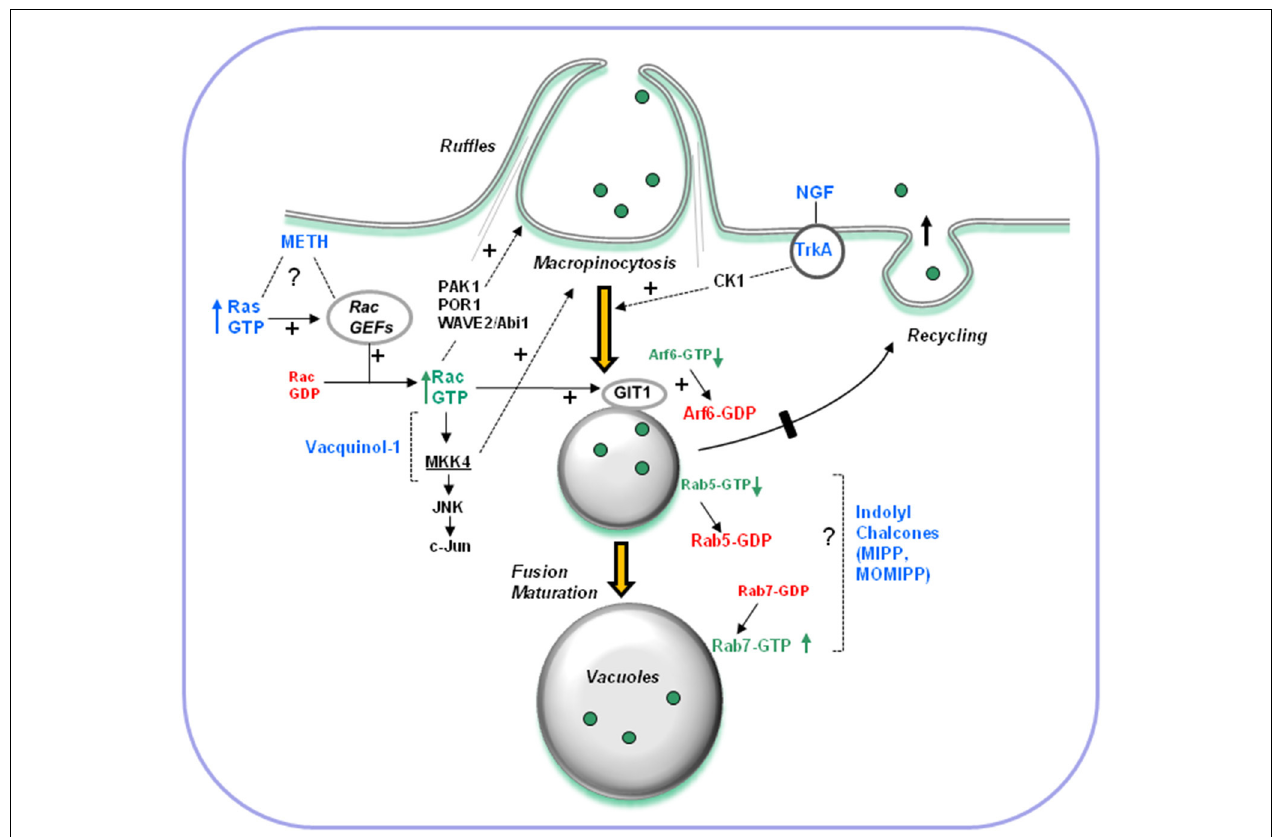
FIGURE 3 | Overview of signaling pathways implicated in hyperstimulation of macropinocytosis and vacuolization of macropinosome-derived compartments. Known stimuli discussed in this review are shown in blue. Dashed lines denote pathways where specific mechanisms and intermediates are not yet defined. Some pathways may be operational only in certain cell types. The effects of constitutively active Ras and high concentrations of METH require activation of Rac1. In addition to altering the amount of active Arf6 via GIT-1, sustained activation of Rac1 has the potential to affect multiple protein targets known to function in actin remodeling, membrane ruffling